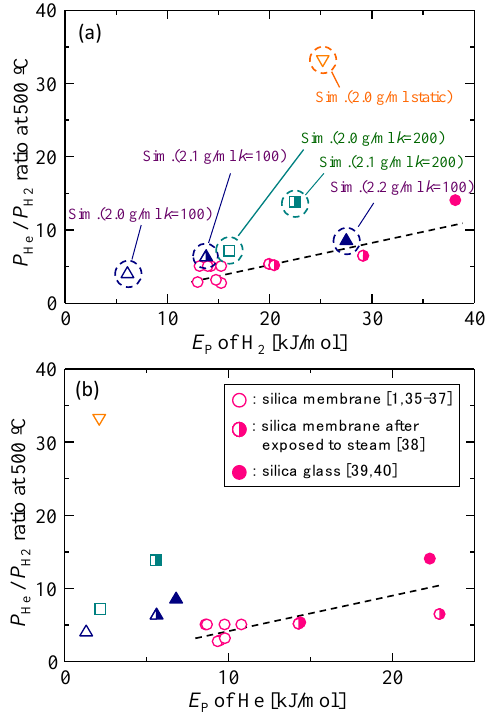
Figure 4. P He / P H2 permeability ratio as a function of the activation energies of hydrogen ( a ) and helium ( b ) [1,35–40].